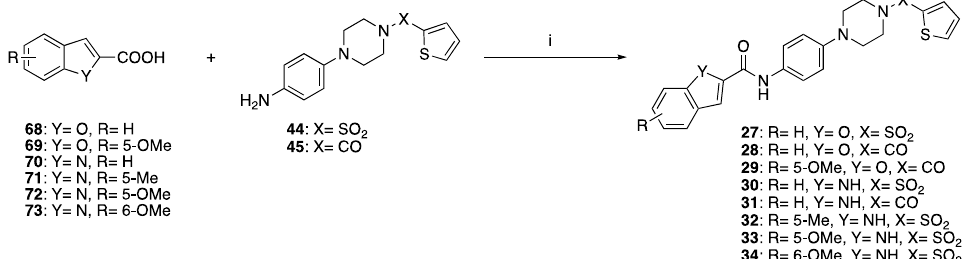
Figure 2. Flexible Alignment results for compounds 27, 28, 30 and 31 (carbon atoms in lilac) against either 3 (carbon atoms in light blue) or 4 (carbon atoms in green), showing the high degree of structural overlapping between the newly designed compounds and the original hit scaffolds.